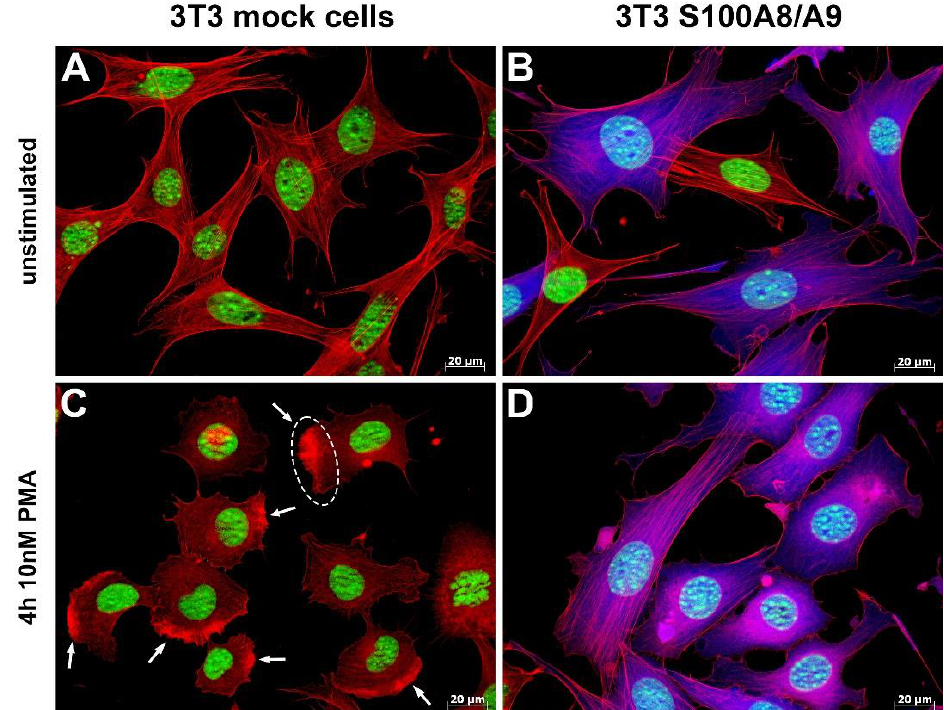
Figure 4. S100A8/S100A9 expression impaired cell polarization and lamellipodia formation. Un- stimulated non-expressing control cells ( A ) and S100A8/S100A9-transfected cells ( B ) showed no differences in the overall cell morphology or actin-based cytoskeleton (note: transfection efficiency of S100A8/S100A9-transfected NIH 3T3 cells was not 100%). Upon PMA stimulation (10 nM/4 h), con- trol cells ( C ) exhibited highly increased membrane dynamics (arrows and encircled example area: formation of lamellipodia/membrane ruffles) and spontaneous migration. In contrast, S100A8/S100A9-expressing cells ( D ) failed to polarize properly and to induce lamellipodia formation. Three independent experiments were performed and 25 cells per experiment were analyzed for each individual condition. (red: F-actin, FITC-phalloidin; green: DNA, 4′,6 -diamidino-2-phenylindole; blue: anti-S100A9, DyLight649).